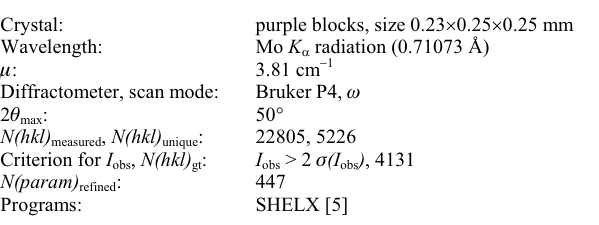
Table 1. Data collection and handling.